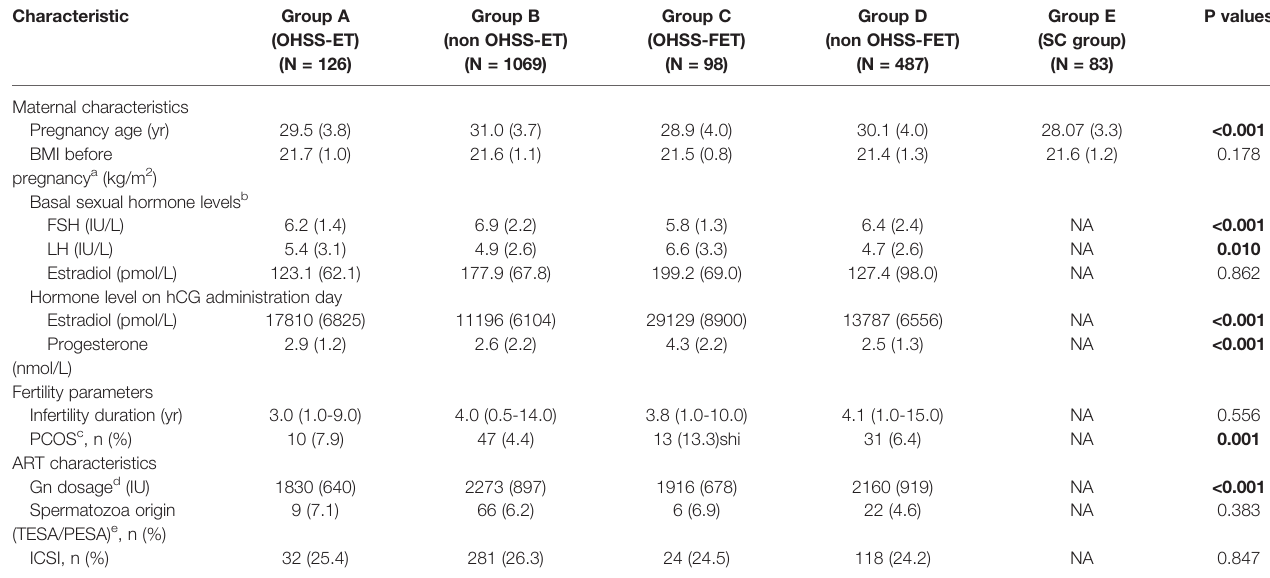
TABLE 1 | Demographic data on mothers, subfertility and ART characteristics.